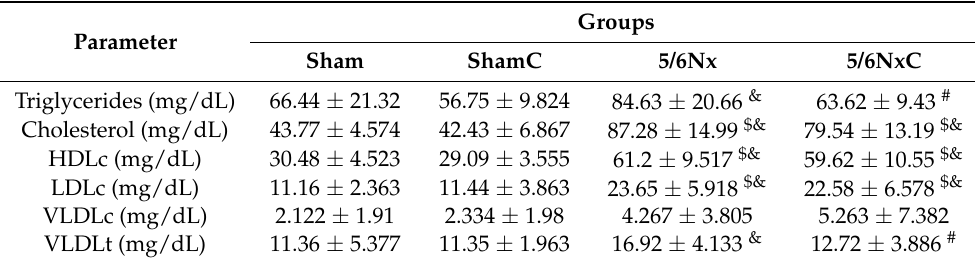
Table 2. Plasma lipid profile.